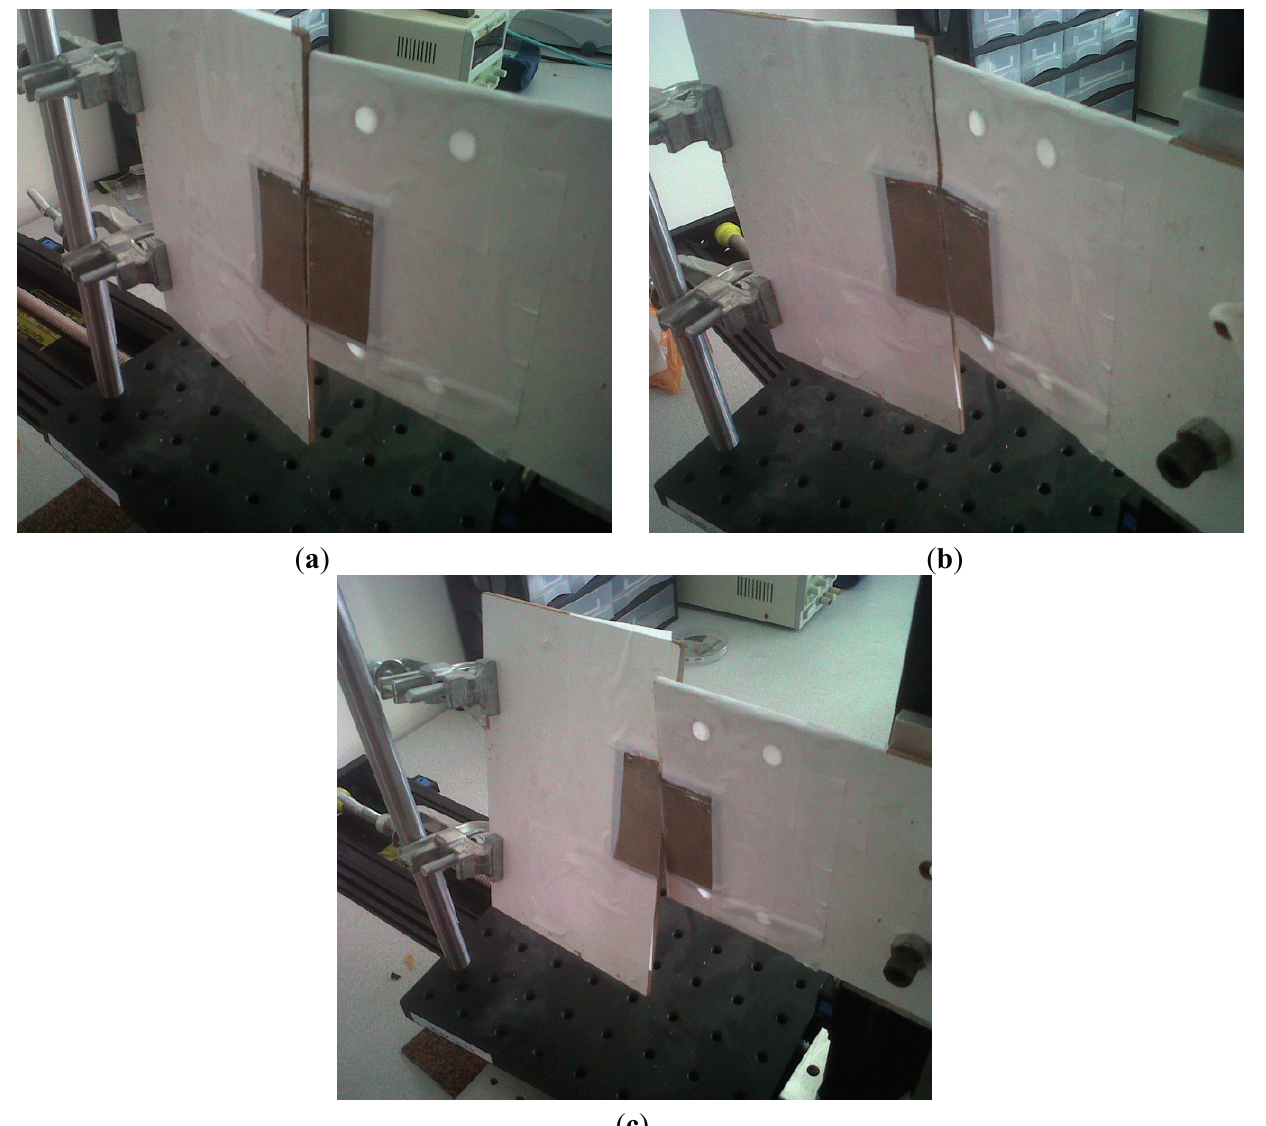
Figure 5. Possible misalignments scenarios of the sensor: ( a ) inward bending of the NSRR probe parts; ( b ) outward bending of the NSRR probe parts; ( c ) twisting of the NSRR probe